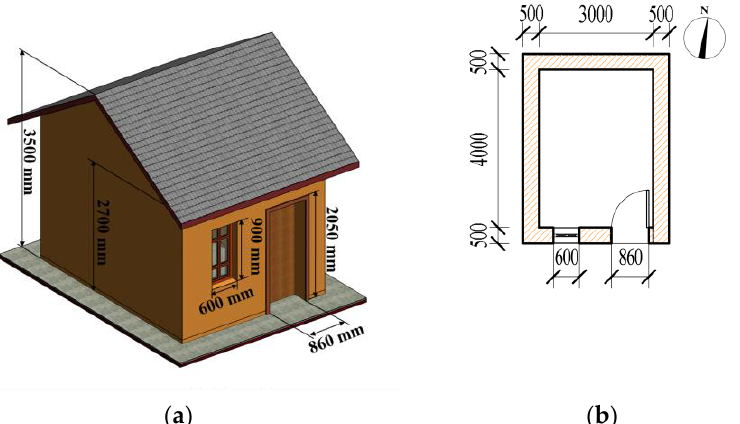
Figure 9. The drawing of simulated rammed earth folk house: ( a ) the 3D drawing of simulated rammed earth folk house; ( b ) plan of the rammed earth folk house.